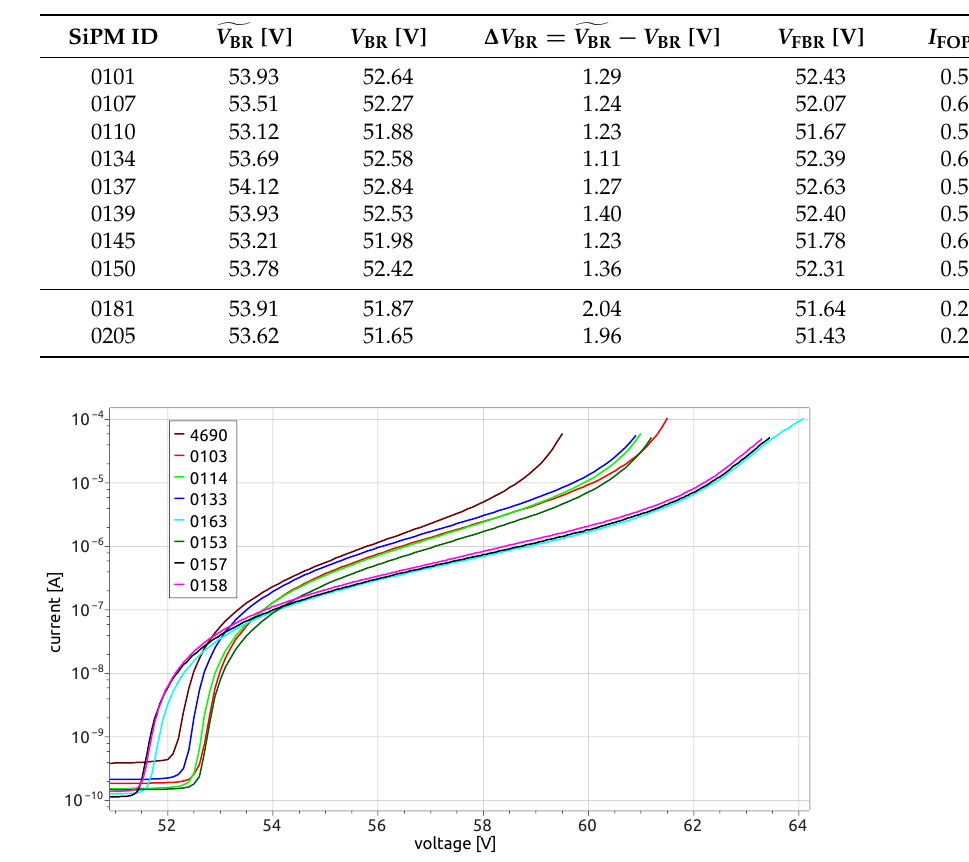
Figure 23. Breakdown voltage V BR (determined using Keithley meter) vs. operational breakdown voltage (cid:103) V BR (determined using AFE meters). Table 1. The relation between normal and operational breakdown voltages ( V BR and (cid:103) V BR , respec- tively), determined in this study. Values of breakdown voltage V FBR and current at operational voltage I FOP determined at the factory are presented for comparison. Last two rows present SiPMs from the second production batch.